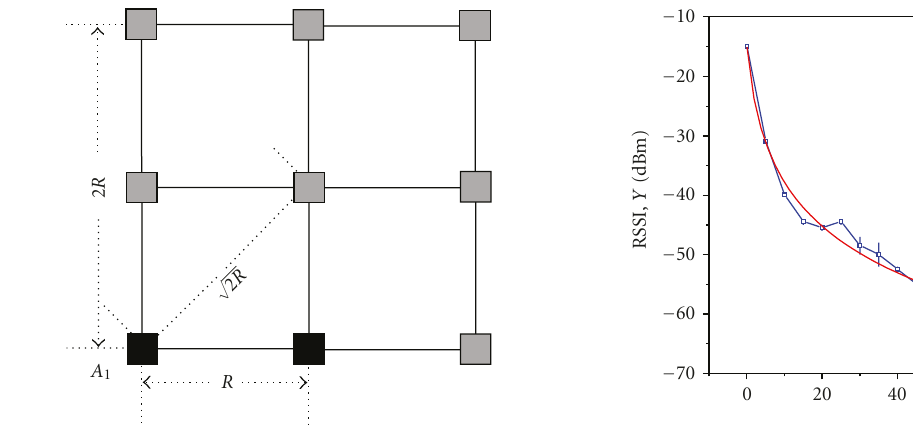
Figure 10: RSSI versus range in a flat open square.